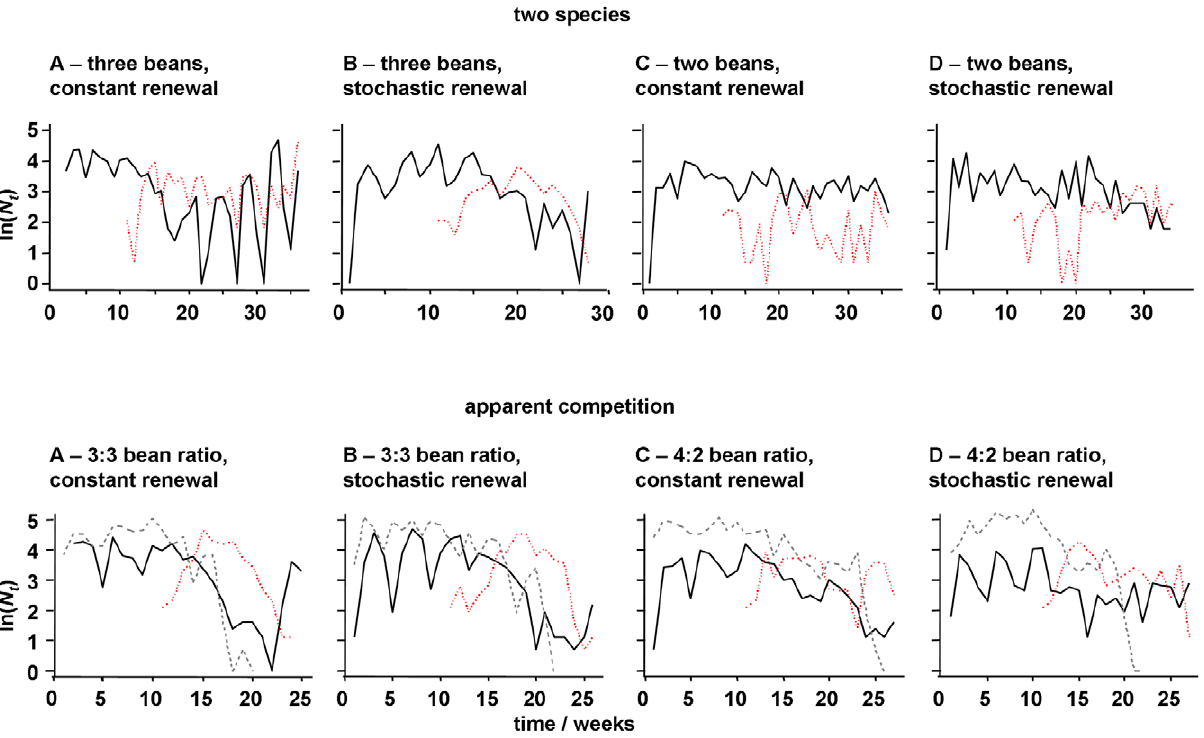
Figure 2. Representative time series of total adult abundances, from the replicated resource-consumer metapopulations, under different resource renewal regimes. Top row: host ( C. maculatus , solid line) – parasitoid ( A. calandrae , dotted line) interaction (patchwise weekly host resource renewal: (a) constant three beans, (b) Poisson average of three beans, (c) constant two beans and (d) Poisson average of two beans). Bottom row: two host species ( C. maculatus , solid line; C. chinensis , dashed line) and one parasitoid species ( A. calandrae , dotted line) apparent competition interaction (patchwise weeklyhost resourcerenewal: (a) constant3:3ratioofbeans perhost species, (b) Poissonaverage 3:3ratioof beans per hostspecies,(c)constant 4:2 ratio, C. chinensis : C. maculatus , of beans and (d) Poisson average 4:2 ratio, C. chinensis : C. maculatus , of beans).